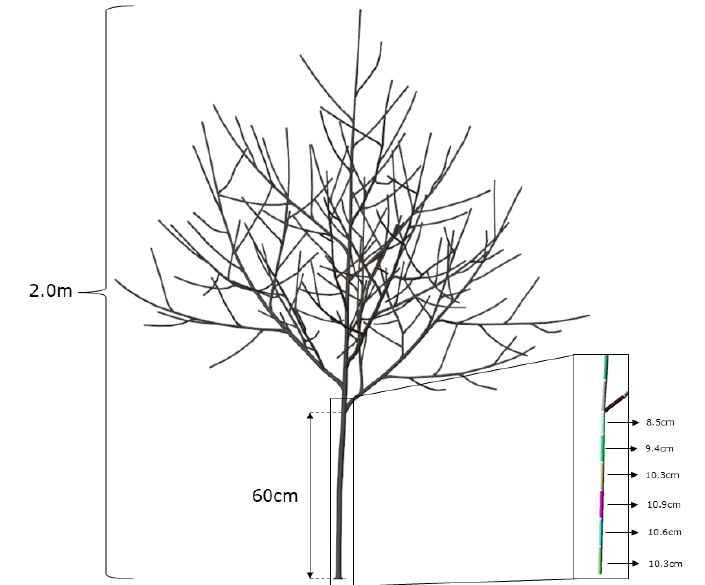
Figure 12. Tree growth with dynamically time changing environmental temperature, fixed light source (top) and amount, 55° branching angle and 2 children branches.